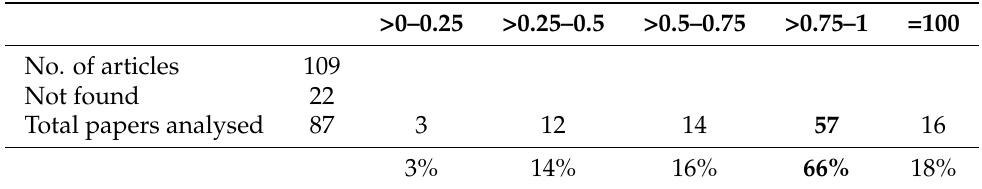
Table 5. Number of items per score range.